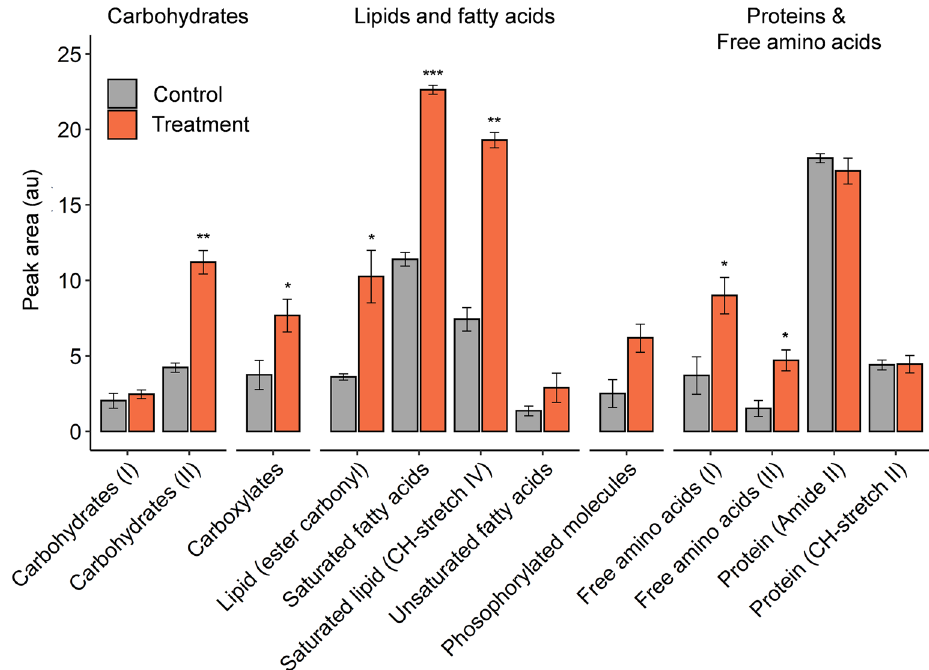
Figure 2. Macromolecular content of control (grey) and heat-treated (orange) symbionts measured by FTIR microspectroscopy. Data represent mean relative content of detected biomolecules ± standard error ( n = 4). Asterisks denote significant differences (paired t-test) between control and treatment at * < 0.05, ** < 0.01, *** < 0.001.